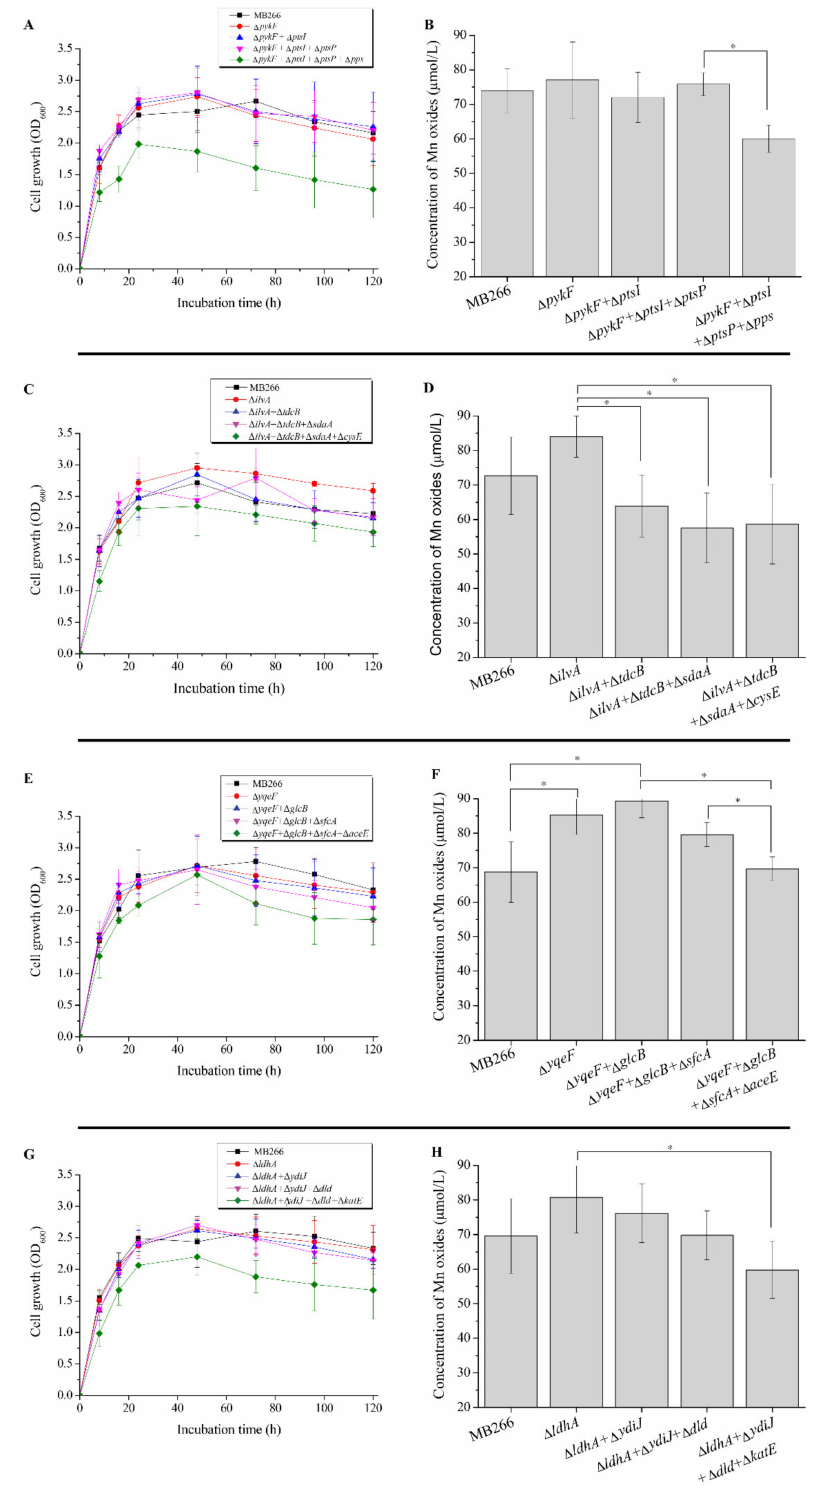
Figure 3. Measurements of the growth curve and MnODA of various gene-knockout mutant strains. ( A , C , E , G ) Growth curve; ( B , D , F , H ) MnODA (refers to concentration of Mn oxides) of ( A , C , E , G ). ( A , B ), pyruvate metabolic pathway; ( C , D ), glucogenic amino acid metabolic pathway; ( E , F ), glyoxylic acid metabolic pathway; ( G , H ), lactic acid metabolic pathway. The wild-type strain MB266 was used as the control for all measurements. Means followed by * in a column were significantly different ( n = at least 3; p <